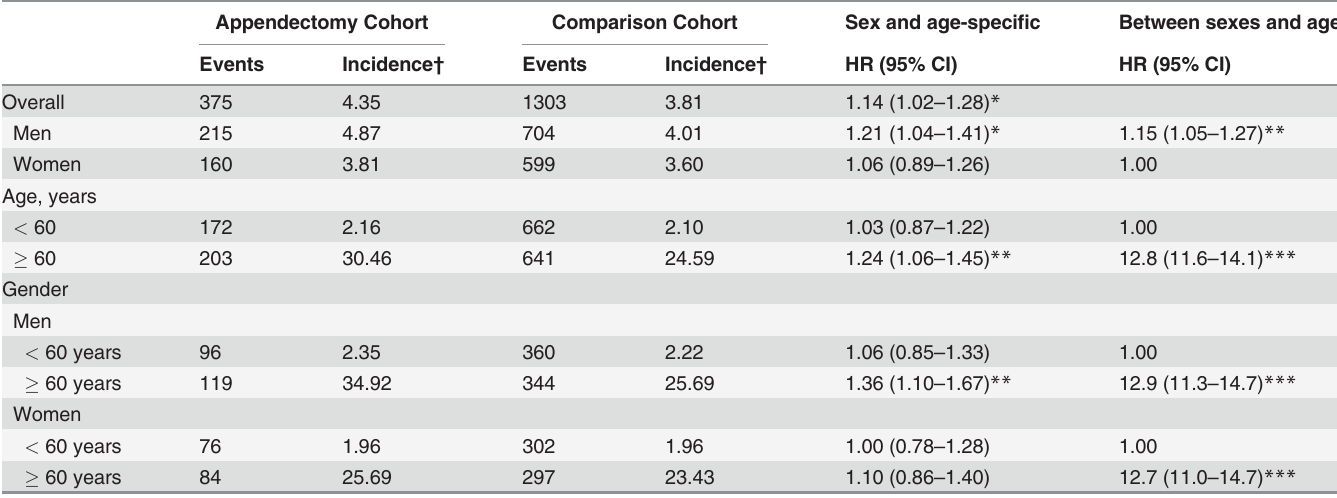
Table 2. Incidence and hazard ratios of colorectal cancer by age and gender. Appendectomy Cohort Comparison